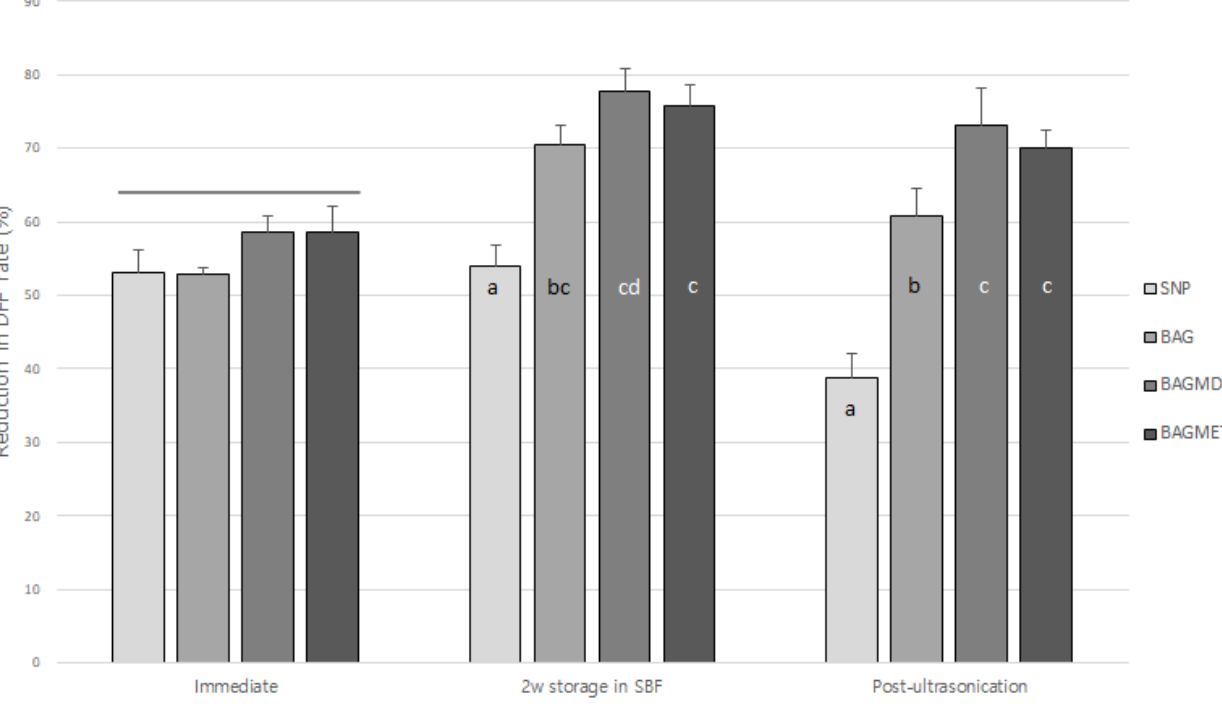
Figure 2. Changes in dentin fluid flow reduction rate of experimental groups at three different timepoints. Different letters indicate statistically significant differences between the materials at each timepoint. Long bar means no significant differences among groups. Table 2. Real-time changes in DFF rate and ∆ DFF (n = 5).